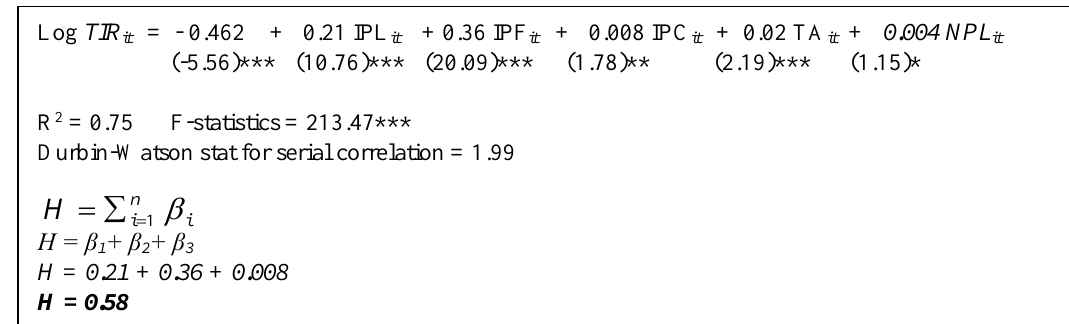
Table 2: Estimation output of H